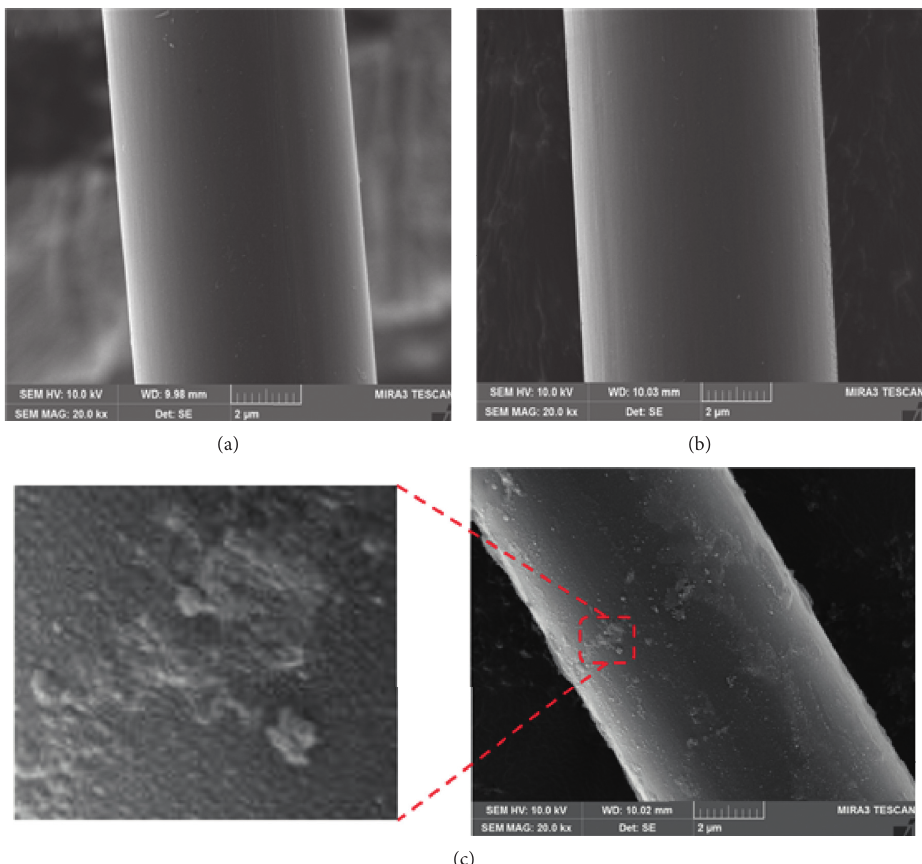
Figure 7: Surface topography of the carbon fiber (20,000x). (a) Plain carbon fiber. (b) Nitric acid-treated carbon fiber. (c) Nano-SiO carbon fiber.